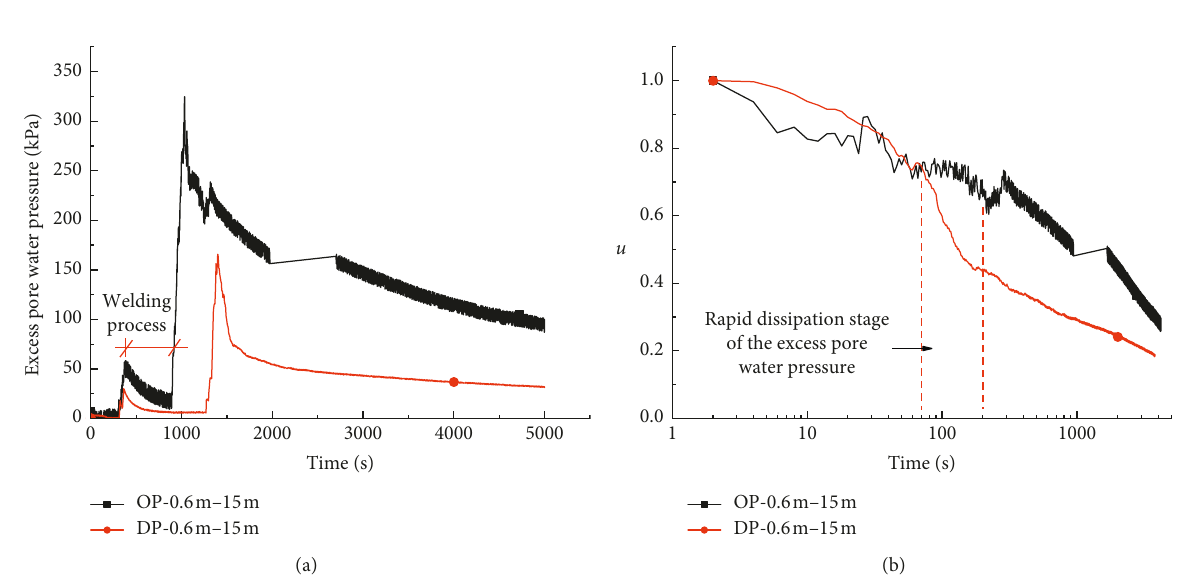
Figure 5: Diagram of the pile